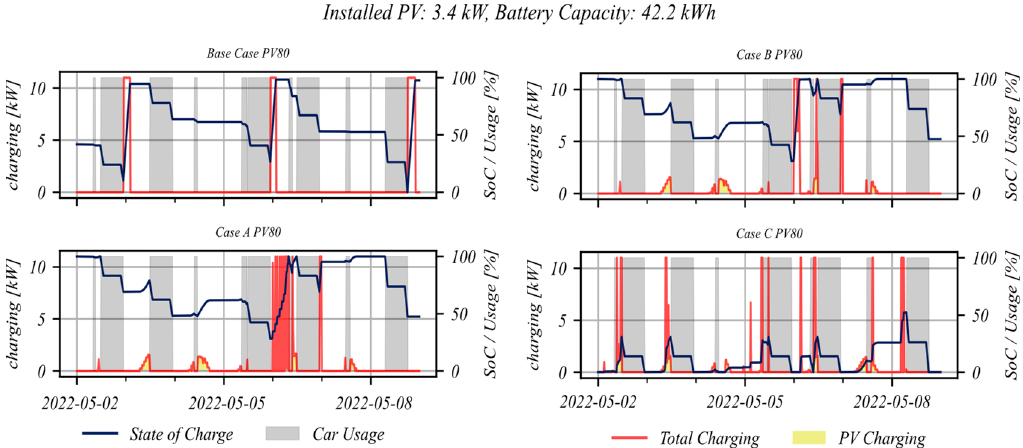
Figure 5. Exemplary resulting charging curves of the same EV visualized for the Base Case , Case A , Case B , and Case C with 80% installed PV potential on buildings in the simulation.